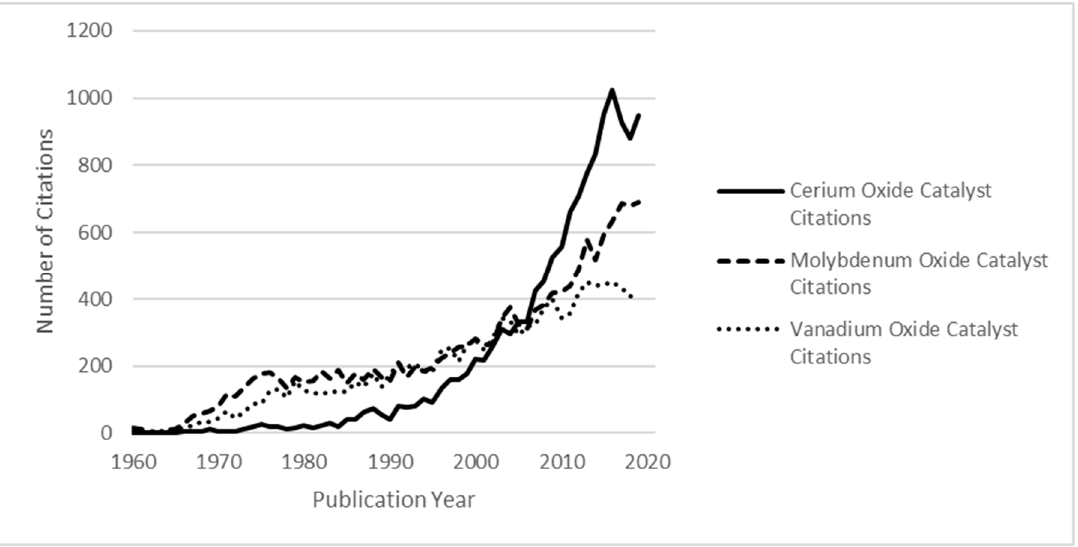
Figure 1. Publications per year on cerium, molybdenum, and vanadium-containing catalysts. Source: SciFinder.